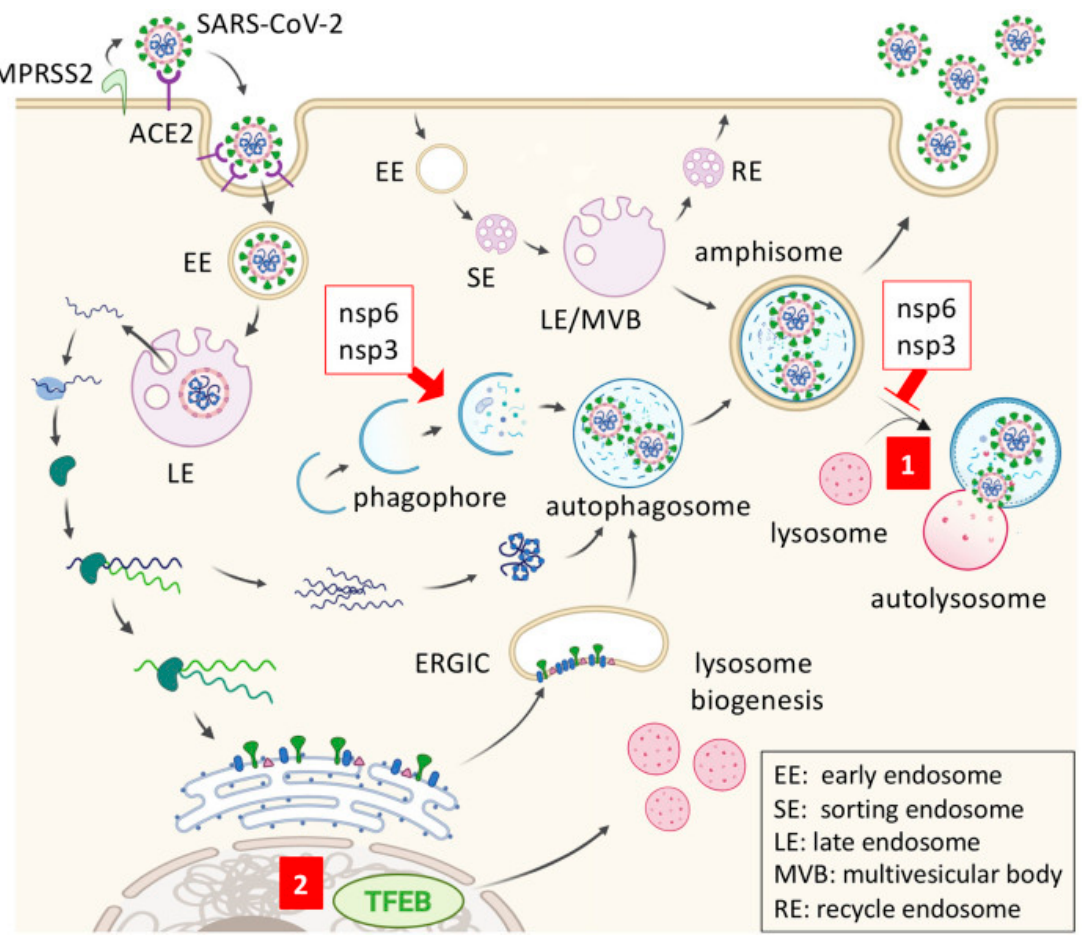
Figure 4. Schematic of antiviral mechanism of trehalose against SARS-CoV-2. SARS-CoV-2 enters the host cell through the interaction of viral spike protein with ACE2 receptor on the cell surface. Coronavirus nonstructural protein 6 (nsp6) and nsp3 promote autophagosome formation but prevent autophagosome-lysosome fusion. ( 1 ) Trehalose may stimulate amphisome-lysosome fusion for virion degradation after the trafficking of viral double-membrane vesicles, ( 2 ) Trehalose activates transcription factor EB (TFEB), and up-regulates lysosome biogenesis. Reproduced from [89] with permission from Frontiers.